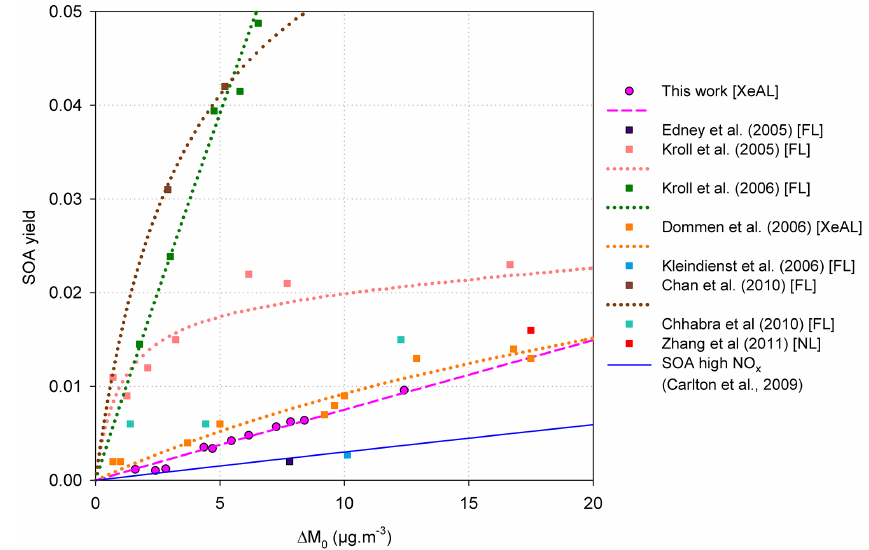
Figure 3. SOA mass yield curves from various isoprene photooxidation experiments in the presence of NO x from the literature compared with the present study. An effective density of 1.4gcm − 3 was used (see text) for conversion to mass of all our volume-based measurements. Light sources used are specified in square brackets (XeAL: xenon arc lamps; FL: fluorescent lamps; NL: natural light). The parameters of our two products yield curve (Odum et al., 1996) are as follows: α 1 = 0 . 508 ; K om , 1 = 7 . 4 × 10 − 4 ; α 2 = 0 . 509 ; K om , 2 = 7 . 4 × 10 − 4